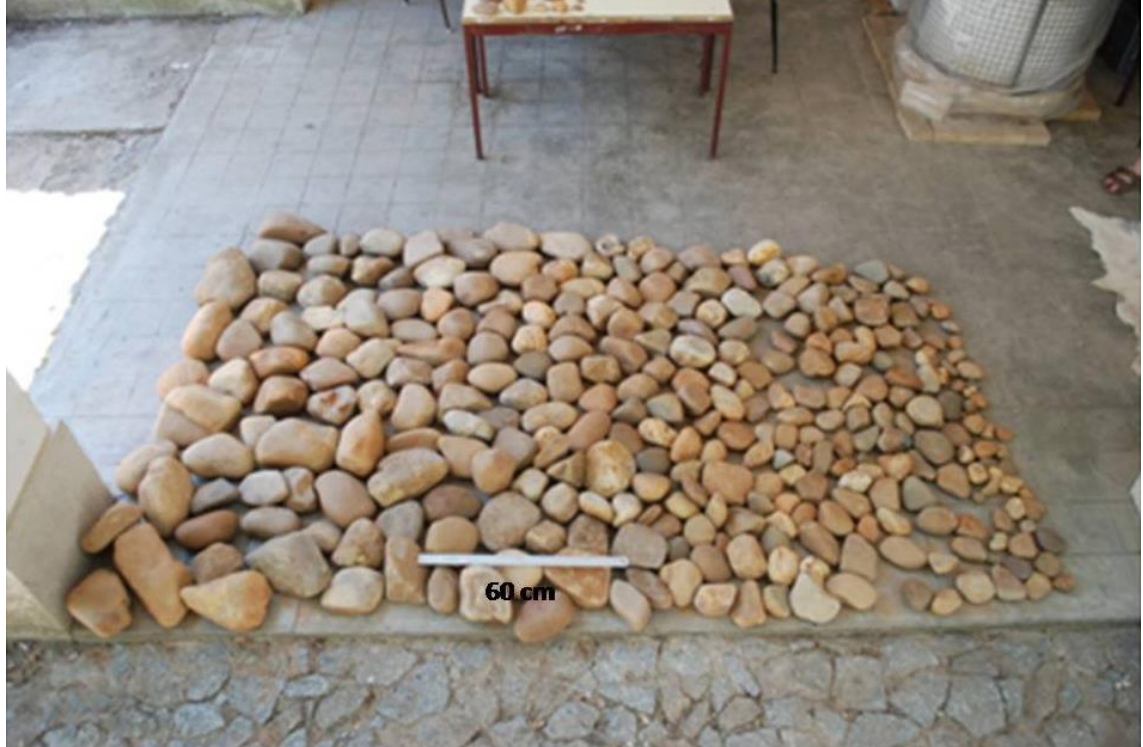
Figure 8. “Natural” sample of 250 pebbles collected in the T4 fluvial deposits in the surroundings of the site.